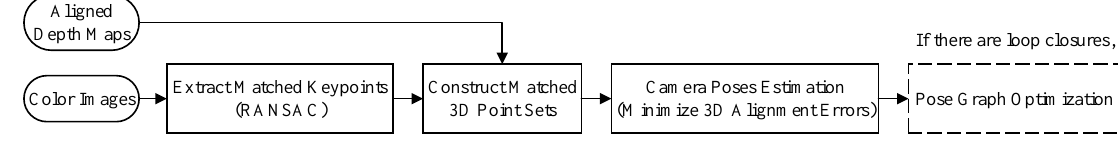
Figure 1. Flow chart of the proposed calibration